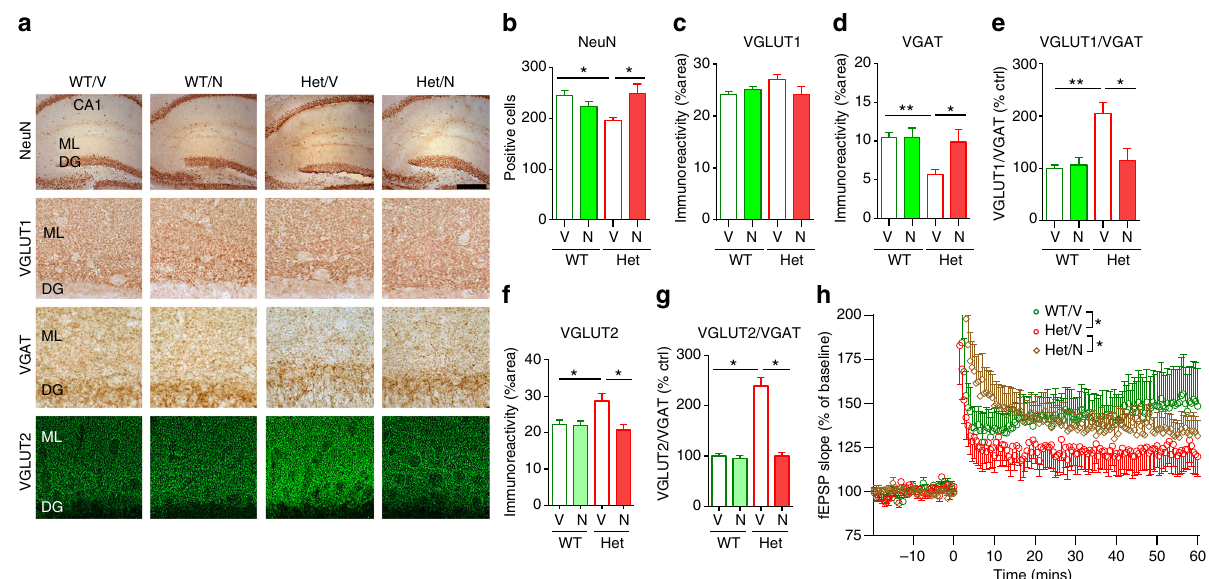
Fig. 7 NitroSynapsin rescues abnormal neuronal and synaptic properties in Mef2c -het mice. a Immunohistochemical images of NeuN, VGLUT1, VGAT, and VGLUT2 in the molecular layer (ML) of the hippocampal dentate gyrus (DG) of WT and Mef2c -het mice treated with vehicle (V) or NitroSynapsin (N). Scale bars: 500 µ m (top panel), 25 µ m (middle panels), 40 µ m (bottom panel). b – f Summary graphs showing rescue by NitroSynapsin of decreased number of total NeuN+ cell counts ( b ), reduced immunoreactivity of VGAT ( d ) and VGLUT2 ( f ), and increased ratio of VGLUT1/VGAT ( e ) or VGLUT2/ VGAT ( g ) in the hippocampus of Mef2c -het mice. h Impaired LTP in Mef2c -het mice was also rescued by NitroSynapsin. Data are mean ± s.e.m., n = 4 – 5 per group in a – g and 7 – 9 in h . * P < 0.05, ** P < 0.01, by ANOVA